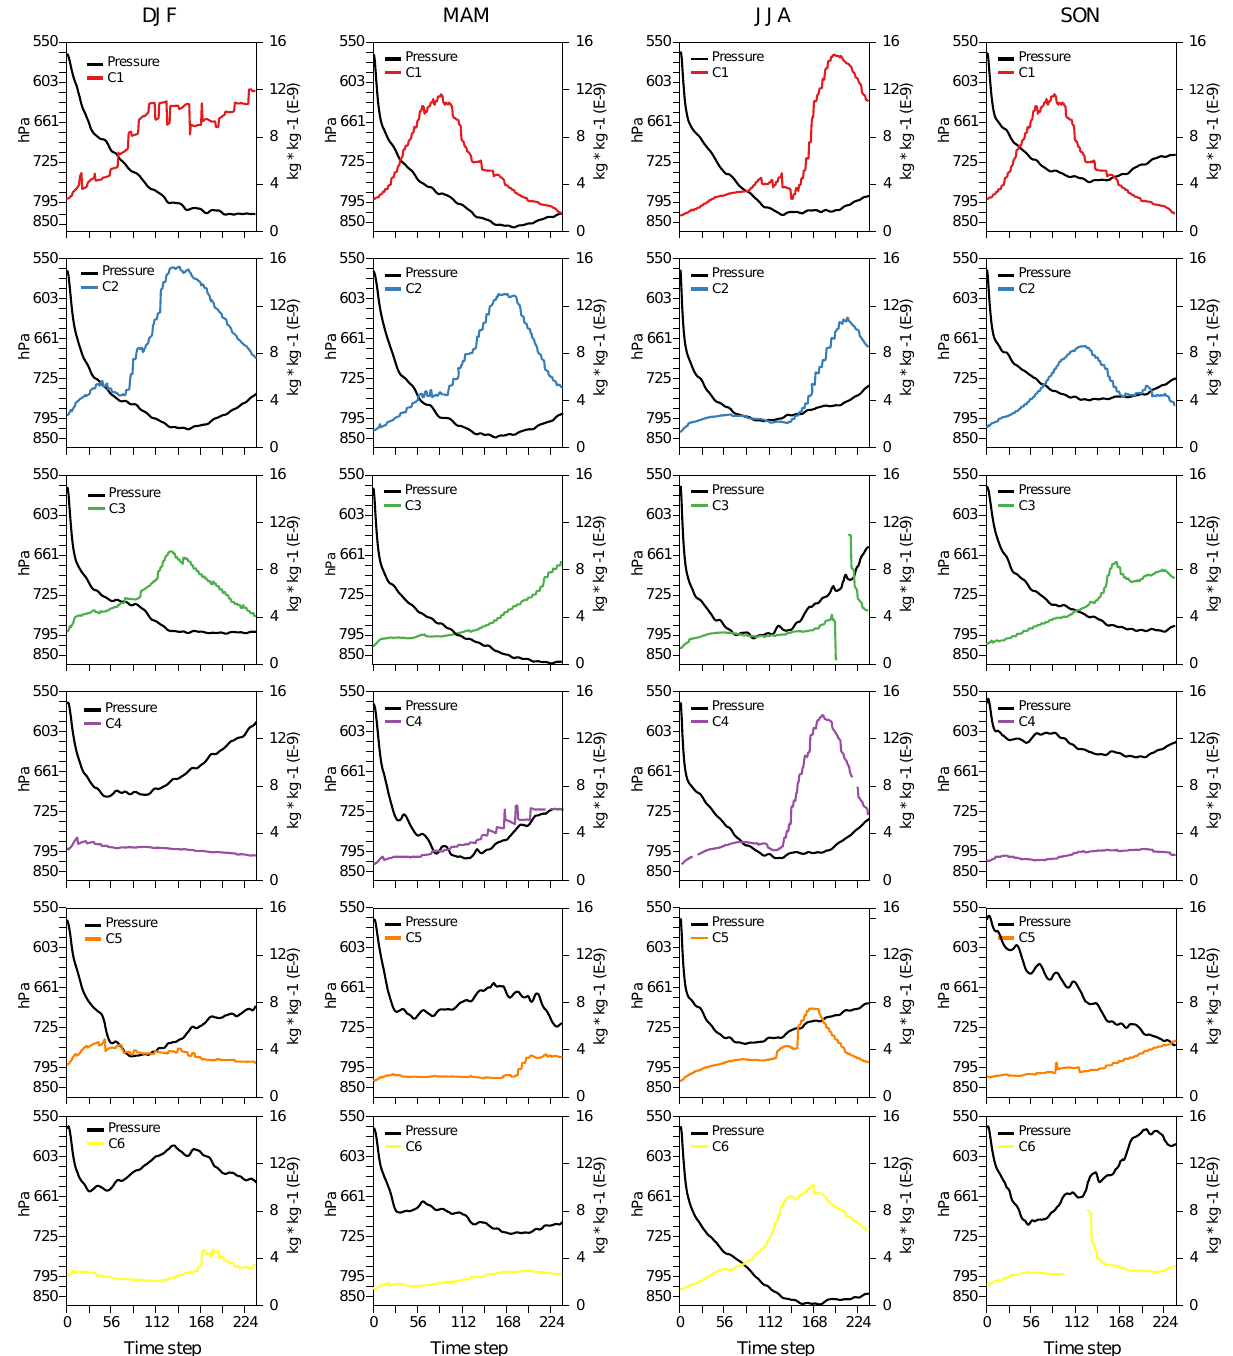
Figure 7. Seasonal plots of sea salt concentration and pressure level along mean back-trajectory clusters. The colours of the sea salt concen- tration lines match those in the trajectory clusters in Fig.